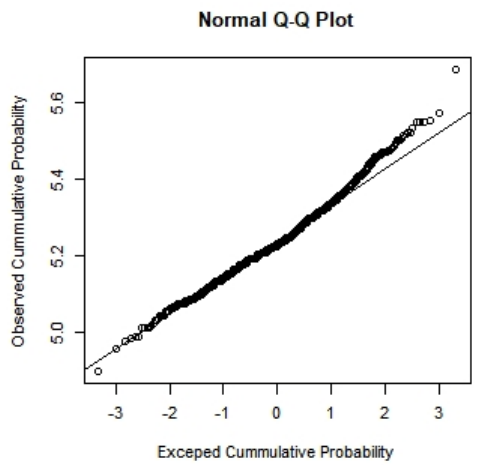
Figure 6. Test results for log(FL). The fit observed cummulative probability to excepted cummulative probability was used to test the distribution of log(FL) was approximately normal.